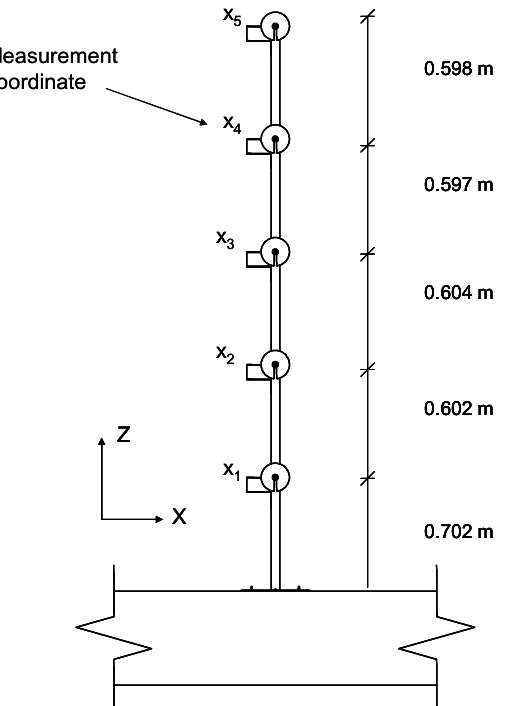
Fig. 4. Tested Model. L = 3.13 m, A = 0.0757 m 2 , I xx = 6.29 × 10 − 4 m 4 , E = 205.4 GPa, W (model and accelerometers) = 24.76